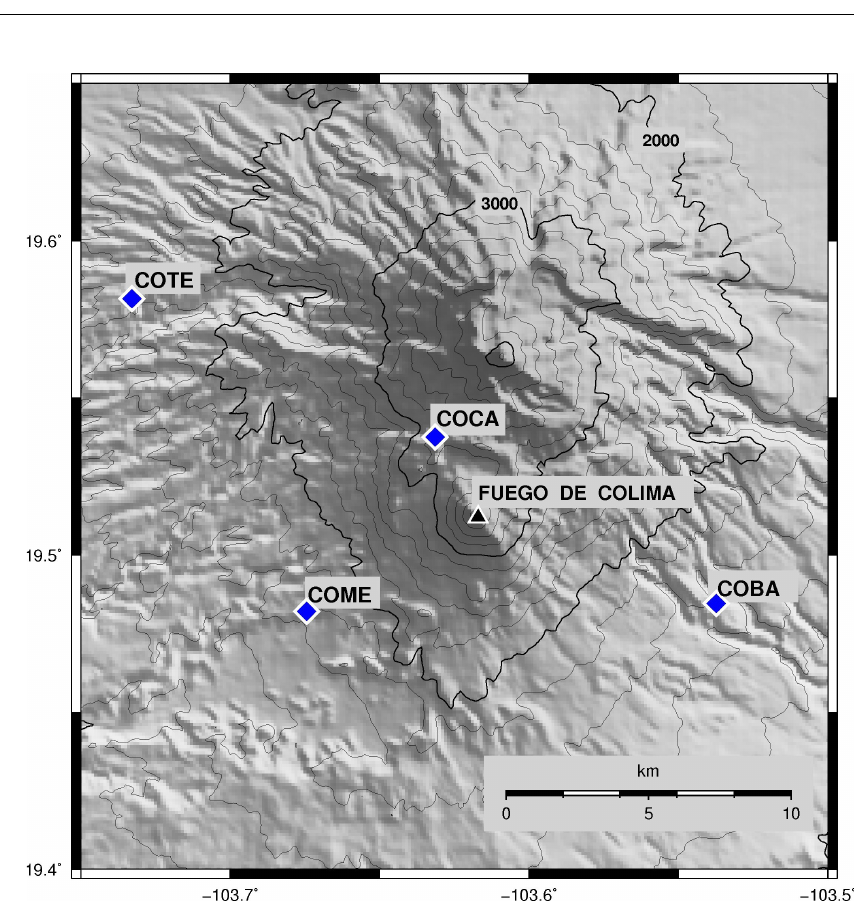
Fig. 1. Topographic contours of Volc ` an de Colima with the location of the four seismic stations (blue diamonds) and of the crater area (black Topographic contours of Volcàn de Colima with the location of the four seismic stations (blue diamond) and of the crater area (black triangle).